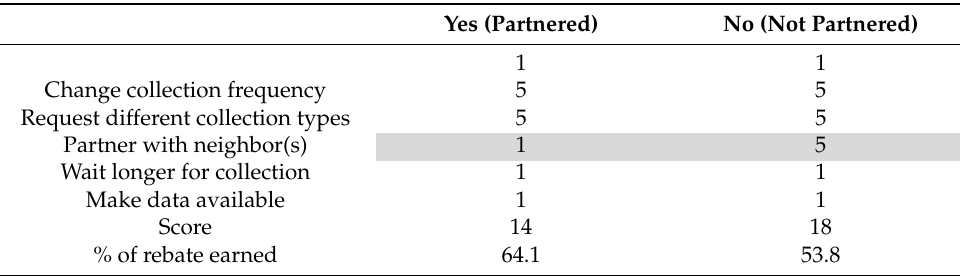
Table 5. Impact of organizing the waste collection with one or more neighbors.